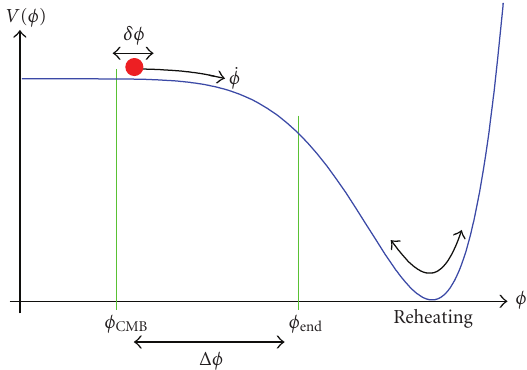
Figure 1: A toy scenario for the dynamics of the scalar field during inflation. During the flat part of potential, universe expand exponentially. When field reaches near the minima of the potential, the field oscillates and the radiation is